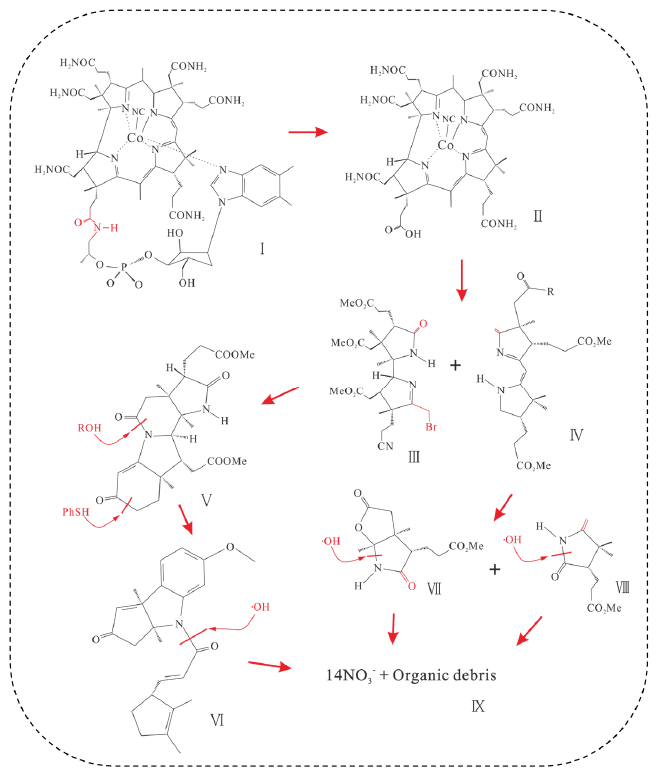
Figure 3. The electrochemical oxidation pathway of VB12. The electrochemical oxidation time is a key factor influencing the oxidation efficiency of VB12. Hence the impacts of oxidation time on oxidation efficiency were investigated in Figure 4a. It was observed in Figure 4a that the reduction current of 1 mg L −1 VB12 with different oxidation times (6, 9, 12, 15, 18, and 21 min) were −0.13, −17.84, −30.21, −31.24, −31.21, and −31.09 μA, respectively. Figure S2 exhibited that the oxidation efficiency of VB12 was enhanced from 56.3 to 96.50% with increasing time from 6 to 15 min and re- mained approximately stable after 15 min. Therefore, 15 min was chosen as the optimum oxidation time. Figure 4b shows the absorption spectra of different concentrations of oxi- dized VB12, showing a clear concentration gradient at 210–250 nm, where it represents that VB12 oxidized to nitrate. Figure 4. Effects of time on ( a ) current values; ( b ) absorption spectra of VB12, oxidized VB12, and potassium nitrate.